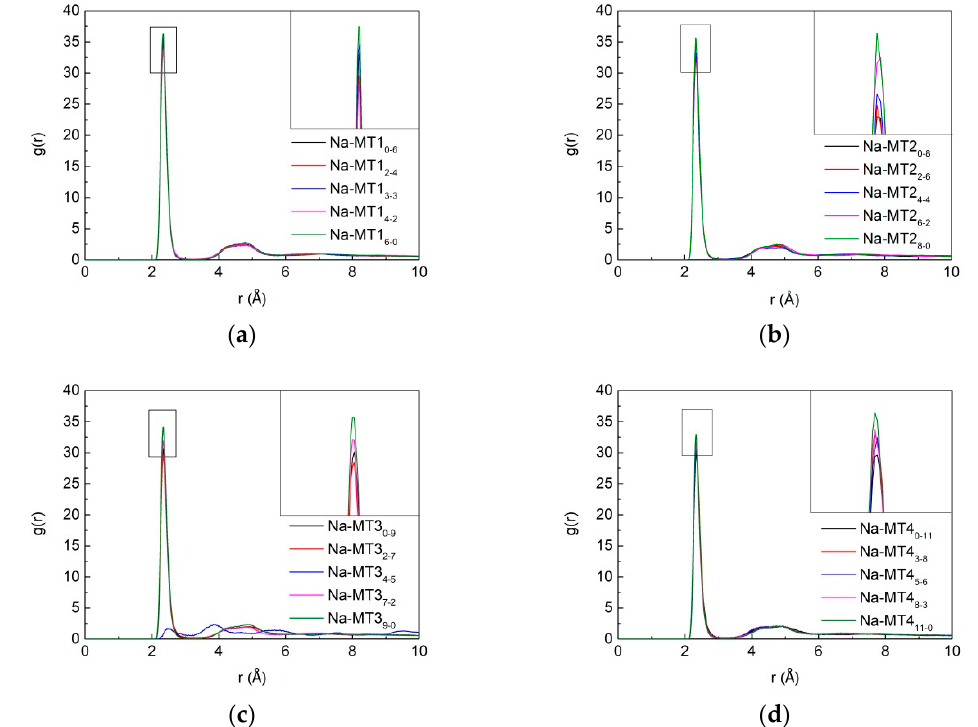
Figure 14. The RDF of Na-O w in Na-MT with different isomorphic substitution sites, ( a ) Na-MT1, ( b ) Na-MT2, ( c ) Na-MT3 and ( d ) Na-MT4.